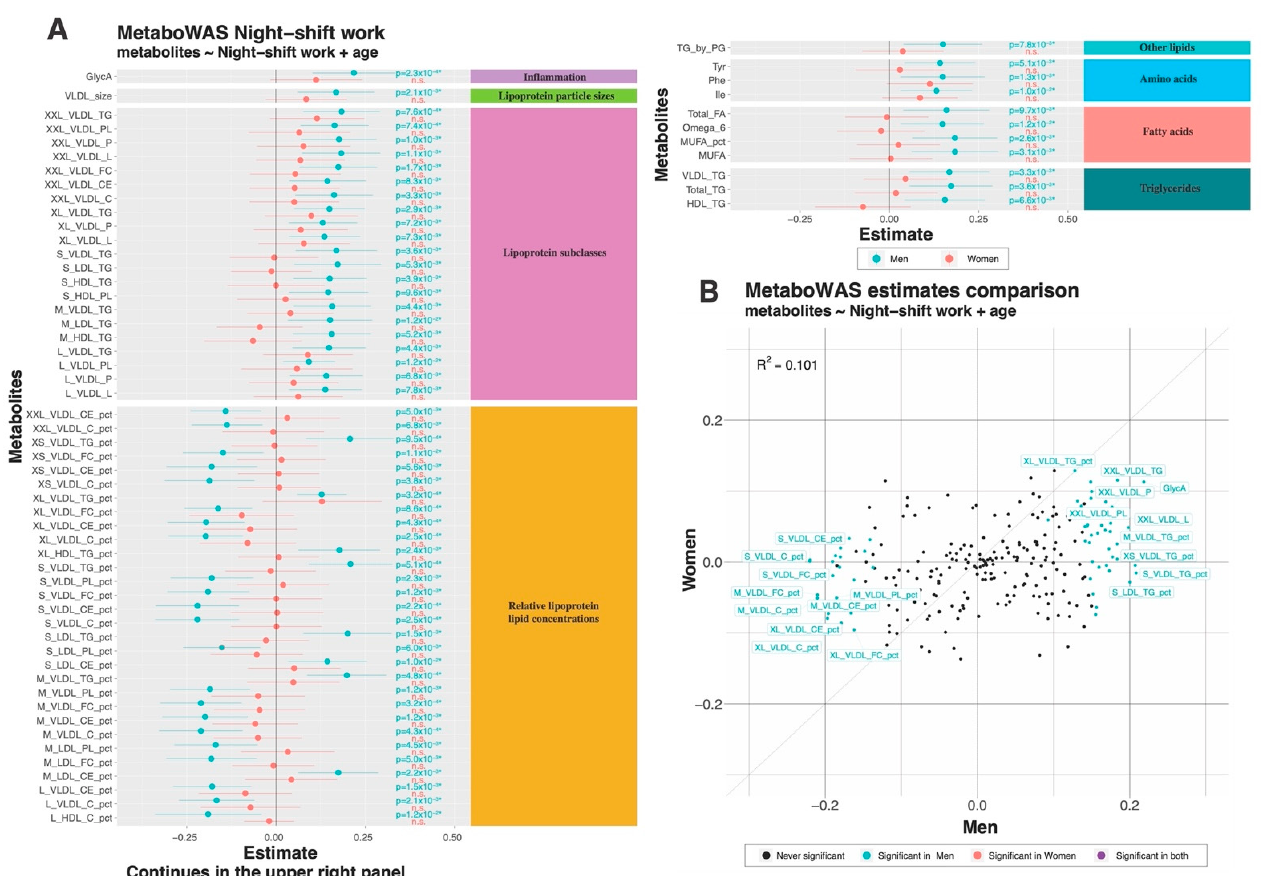
Figure 2. Univariate associations between metabolites (or metabolite ratios) and night shift work, significant in men. ( A ): In men (blue), positive associations were observed between several types of metabolites ranging from inflammation to triglycerides. Negative associations were observed in relative lipoprotein concentrations. In women (pink), no significant associations were observed after Benjamini Hochberg correction. * indicates significant associations and n.s stands for non significant. ( B ): Scatterplot comparing the effect estimates in all metabolites in the Nightingale platform in men (on the x -axis) and women (on the y -axis). Highlighted in blue and tagged are the metabolites significantly associated in men. No metabolite was associated with night shift work in women; therefore, no points are colored red or purple. The analyses are adjusted for age.